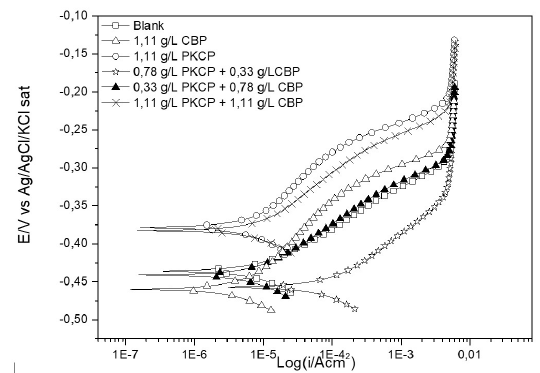
Figure 8. Anodic polarization curves obtained for the ASTM 1020 carbon steel in a 0,5 mol.L -1 HCl solution with various CBP and PKCP concentrations.